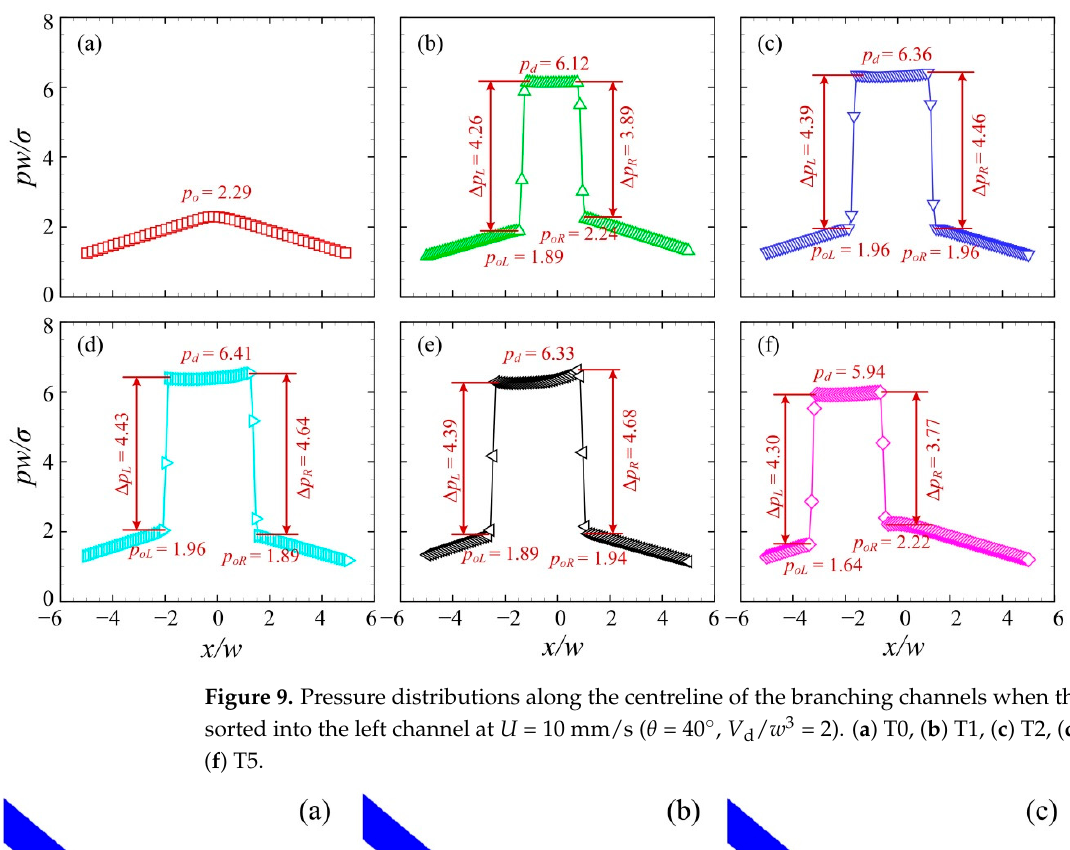
Figure 9. Pressure distributions along the centreline of the branching channels when the droplet is sorted into the left channel at U = 10 mm/s ( θ = 40°, V d / w 3 = 2). ( a ) T0, ( b ) T1, ( c ) T2, ( d ) T3, ( e ) T4, ( f ) T5.